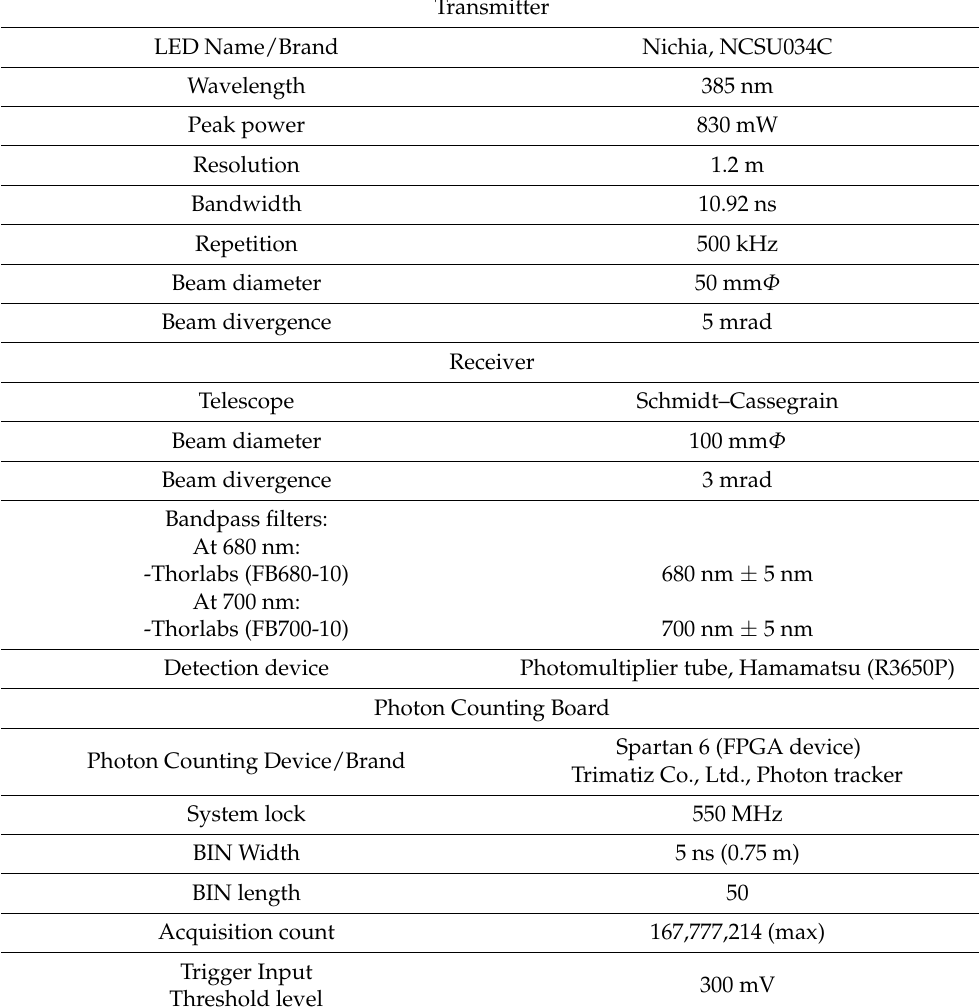
Table 1. Specifications of the LED fluorescence lidar